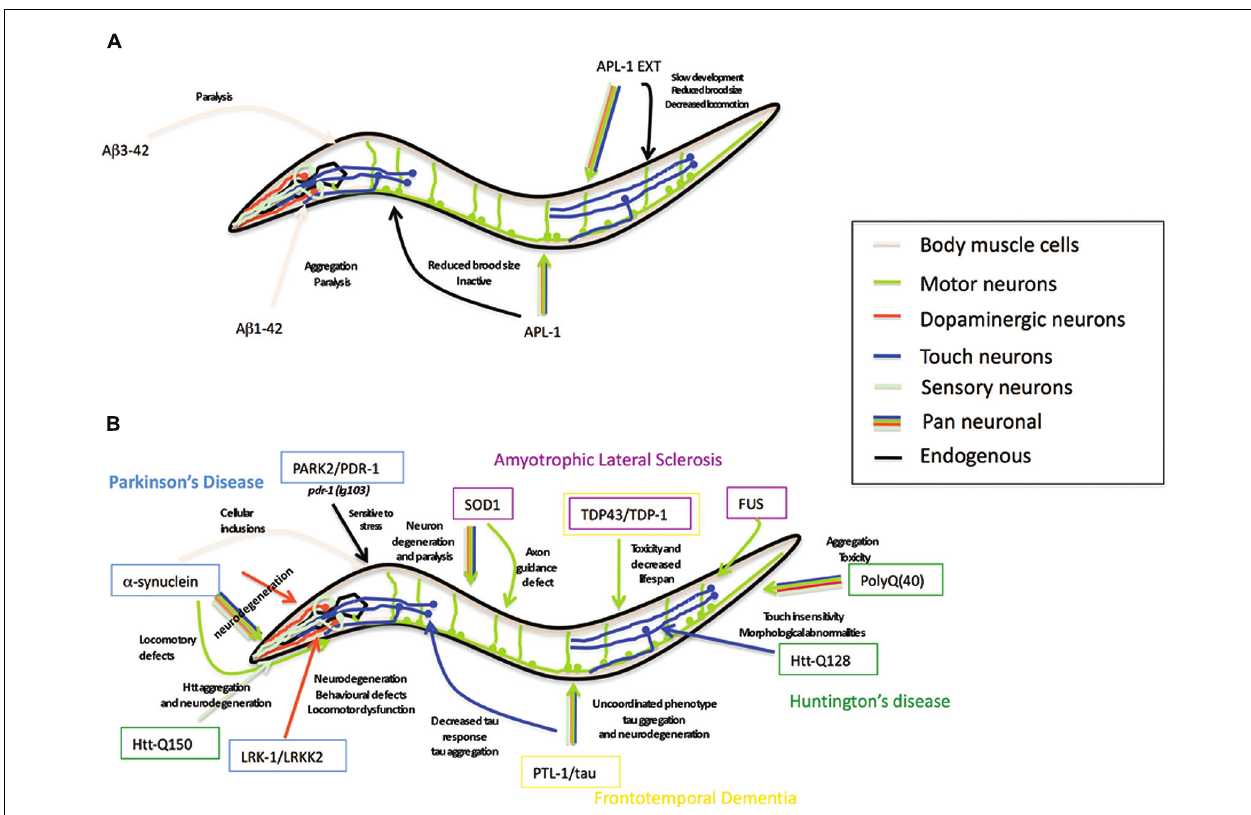
FIGURE 4 | Caenorhabditis elegans as a transgenic model for AD and other neurodegenerative diseases. (A) Summary of the Alzheimer’s disease models in C. elegans expressing human A β peptide or C. elegans full-length APL-1 or APL-1 extracellular domain (APL-1 EXT). Arrow color represents the tissues where transgenes were expressed. Phenotypes observed are next to the arrow. (B) Summary